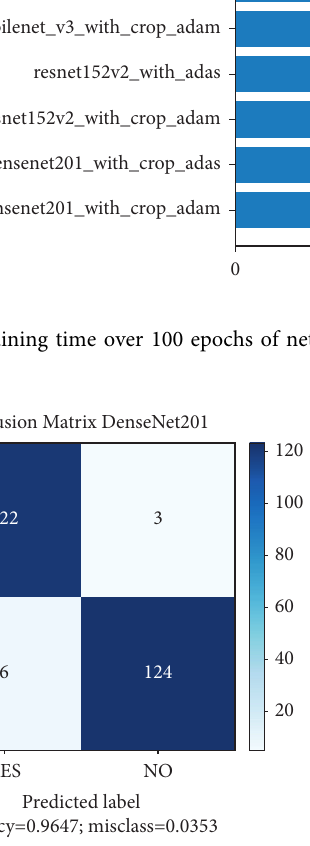
Figure 22: Accuracy evaluation matrix of DenseNet201 network architecture using ADAS optimization algorithm via F1-score.